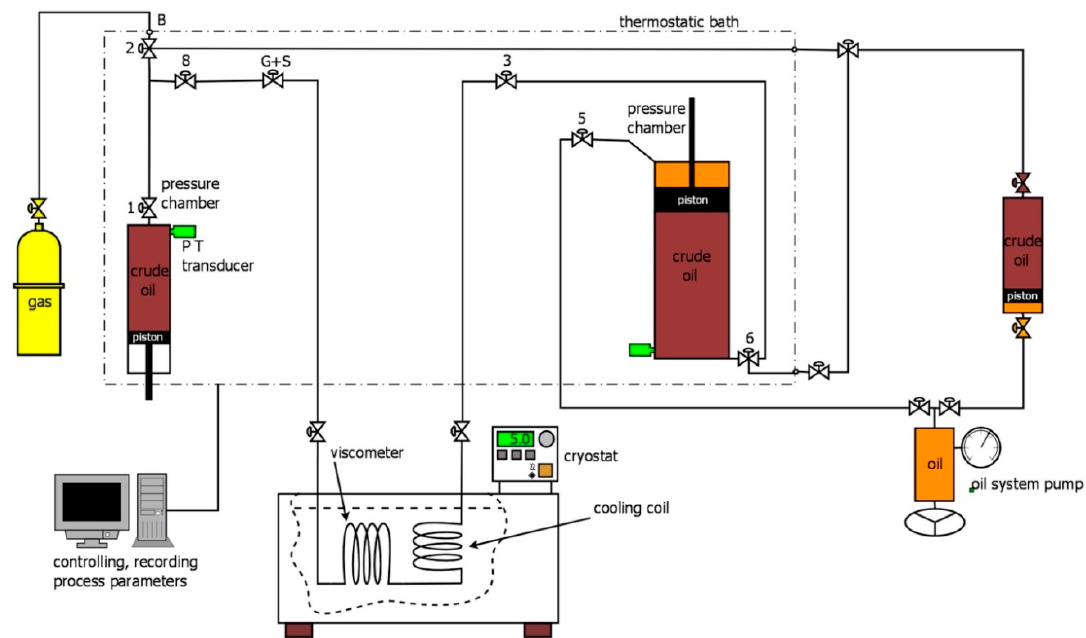
Figure 3. Scheme of PVT apparatus adjusted for determining the precipitation conditions of the solid paraffin phase.